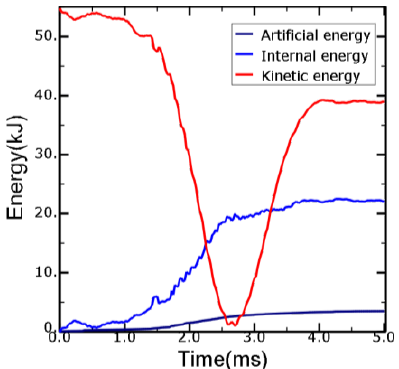
Figure 3. Artificial, internal, and kinetic energy outputs with respect to time.